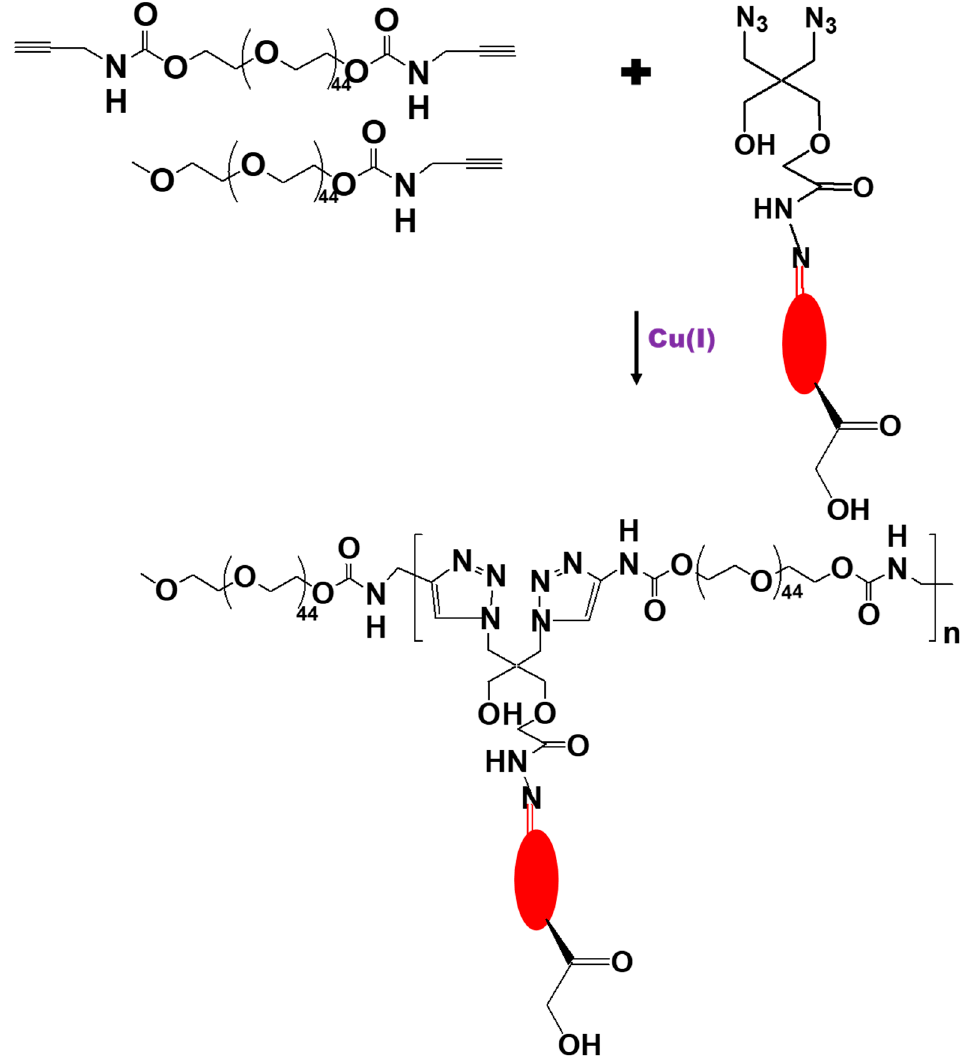
Figure 7. Scheme for the synthesis of a dexamethasone conjugate with acetylene polyethylene glycol by Cu(I)-catalyzed 1,3-dipolar cycloaddition.